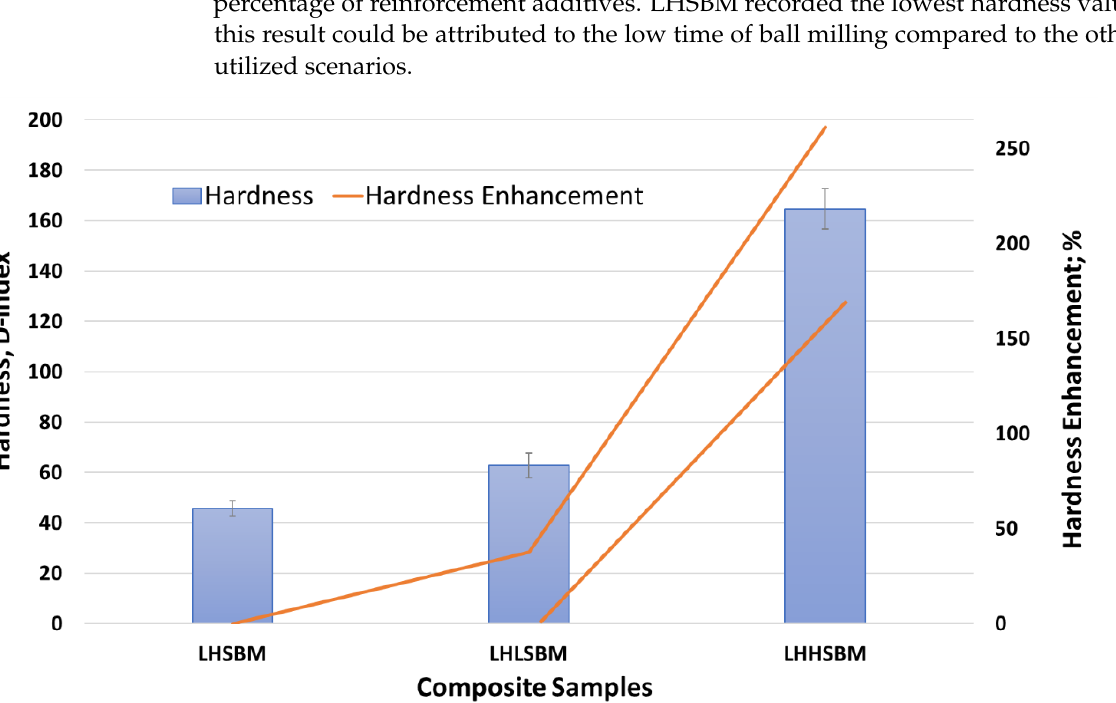
Figure 12. Hardness of the Al/SiC composites with different production scenarios.